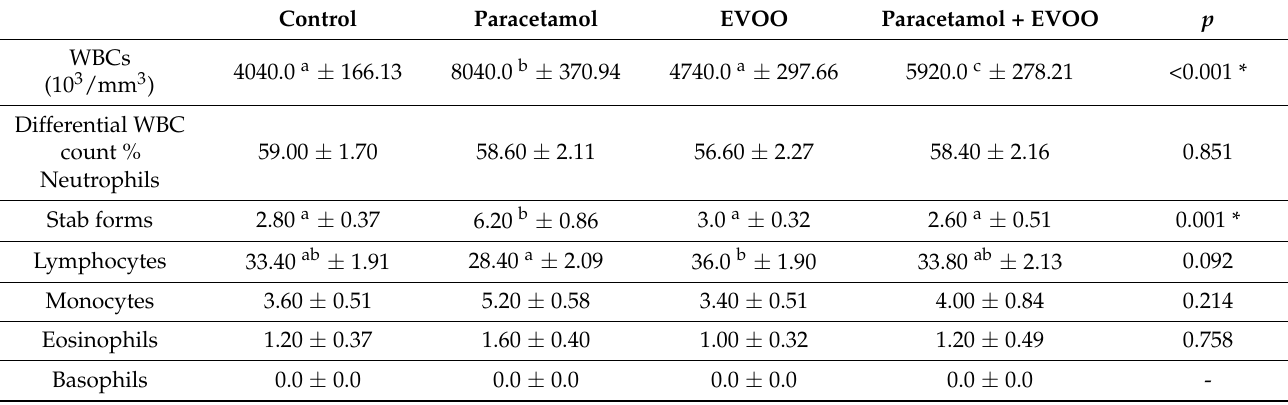
Table 4. Effect of administration of paracetamol and/or EVOO on WBC total and differential counts in male Wistar